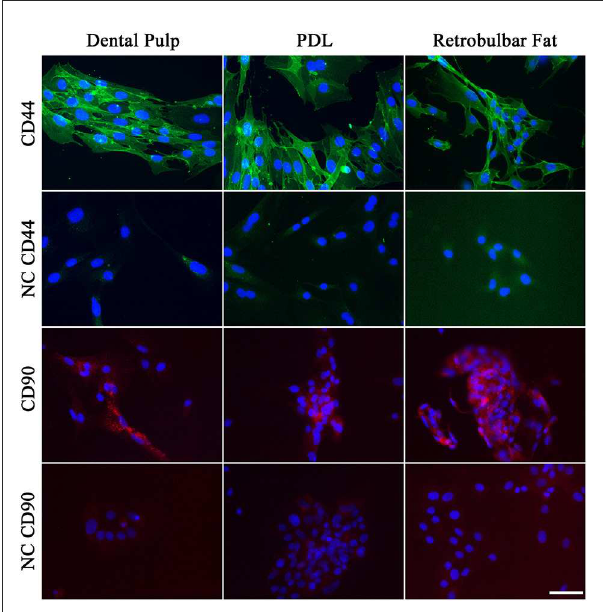
FIGURE8 Immunohistochemistry of MSCs for CD44 (green) and CD90 (red). The nuclei were stained with DAPI (blue). Negative controls (NC) are shown beneath the sample. Scale bar represents 50 µ